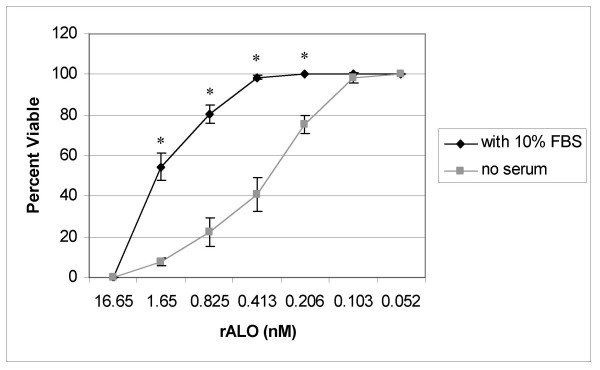
Recombinant ALO lyses primary human lymphocytes in a dose dependent manner. Percent viability of lymphocytes measured with trypan blue after 30 min incubation with varying concentrations of rALO at 37°C with no serum or heat-inactivated 10%. The means and standard deviations of at least three independent experiments, each done in duplicate, are shown (Spearman correlation is -0.964, p < 0.001). Addition of 10% serum significantly inhibits ALO-mediated lymphocyte lysis (*p = 0.001 as calculated by student's unpaired t-test).